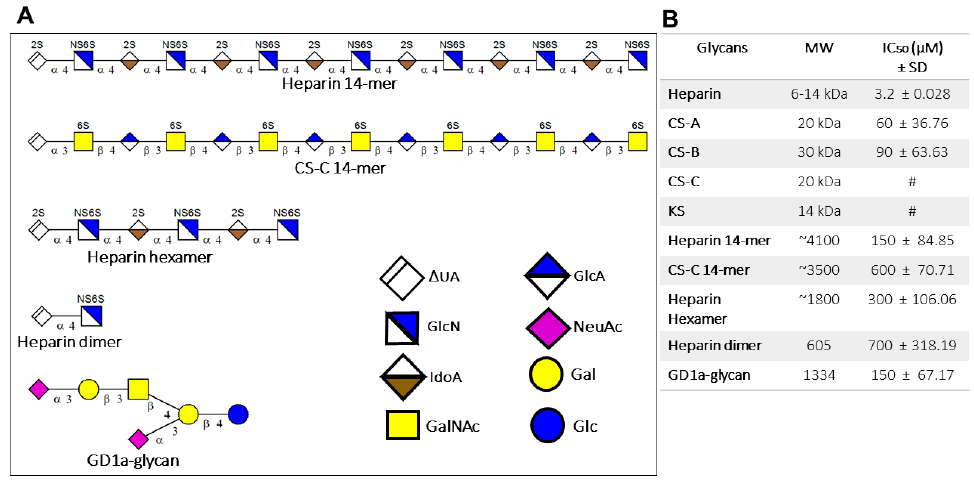
Figure 2. Sulfated GAGs and GD1a-glycan and their effect on HAdV-D37 binding to human corneal epithelial (HCE) cells. ( A ) Only the structures of GAG oligosaccharides are shown as representatives. GAG polysaccharides may exist as a heterogeneous mixture of GAG chains. Structure of GD1a-glycan is also shown. ( B ) Inhibitory effect of sulfated GAGs and GD1a-glycan on 35 S-labeled HAdV-D37 virus binding to cells. The figure shows the MWs of sulfated GAGs and GD1a-glycans and their corresponding IC 50 values. # IC 50 level was not reached.